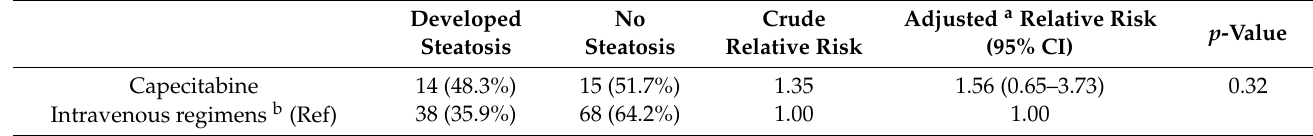
Table 4. Capecitabine compared to 5-FU-containing intravenous regimens and development of steatosis.